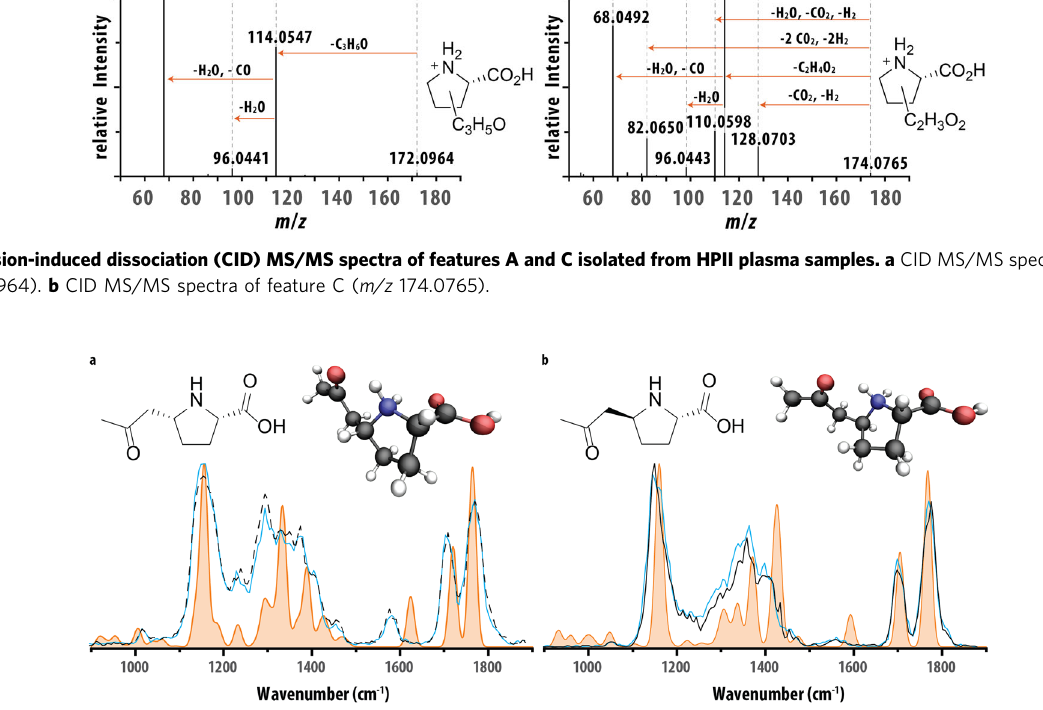
Fig. 3 Con fi rmation of the structural assignment of feature A and B with synthetic reference standards. Comparison of the experimental IR spectra of a feature A (black trace) and reference standard 4 cis (blue line) with theoretical IR spectrum of 4 cis (orange trace), b feature A (black trace) and reference standard 4 trans (blue line) with theoretical IR spectrum of 4 trans (orange trace). Molecular structures corresponding to the protonated reference standards are inlayed in each